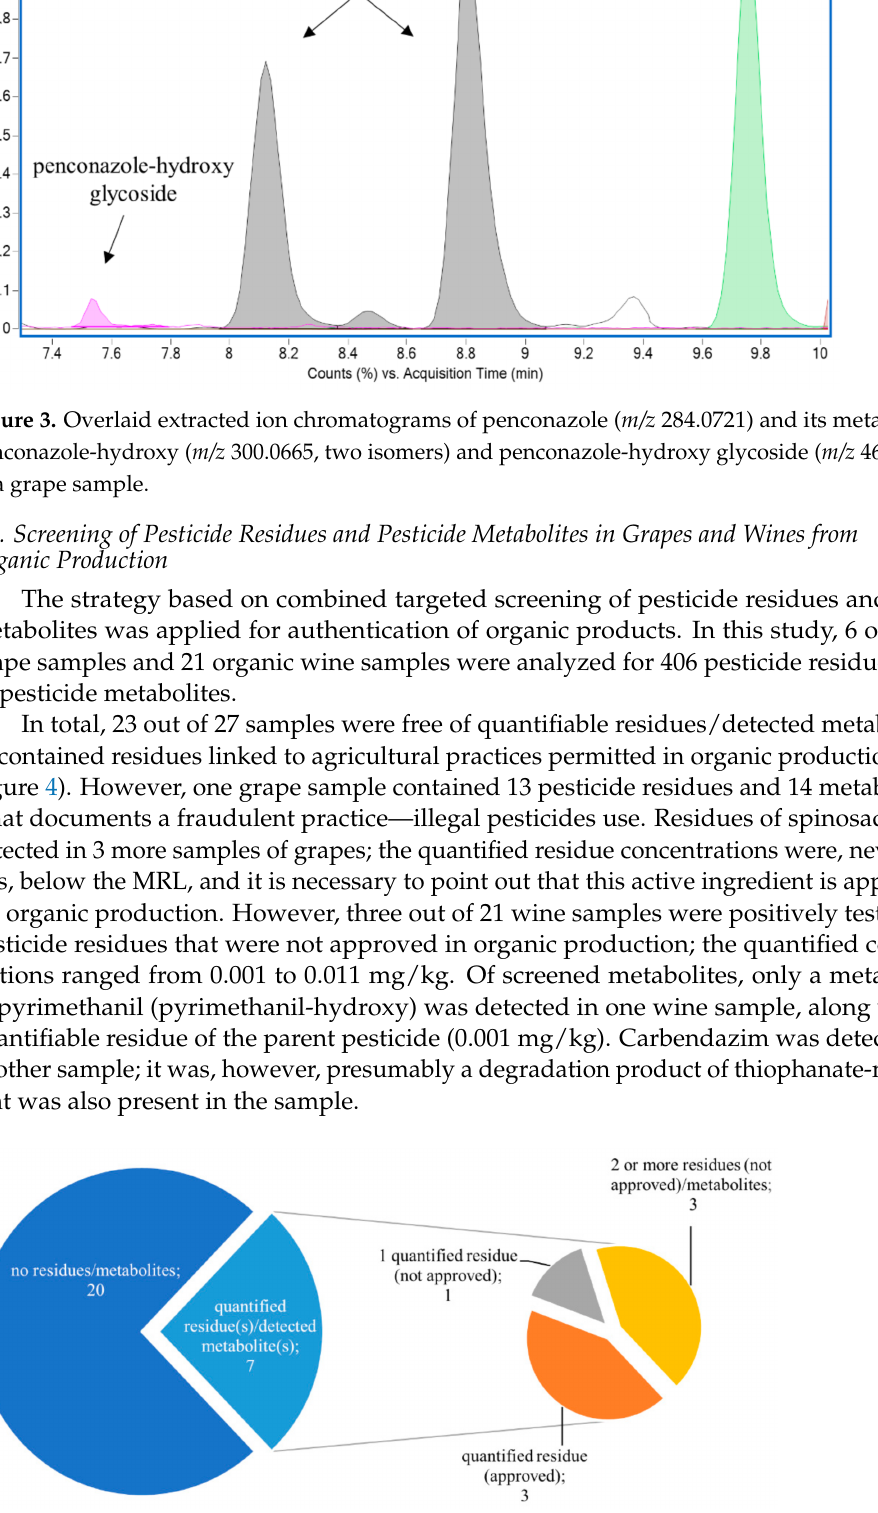
Figure 4. The number of quantified residues/detected metabolites in samples from organic